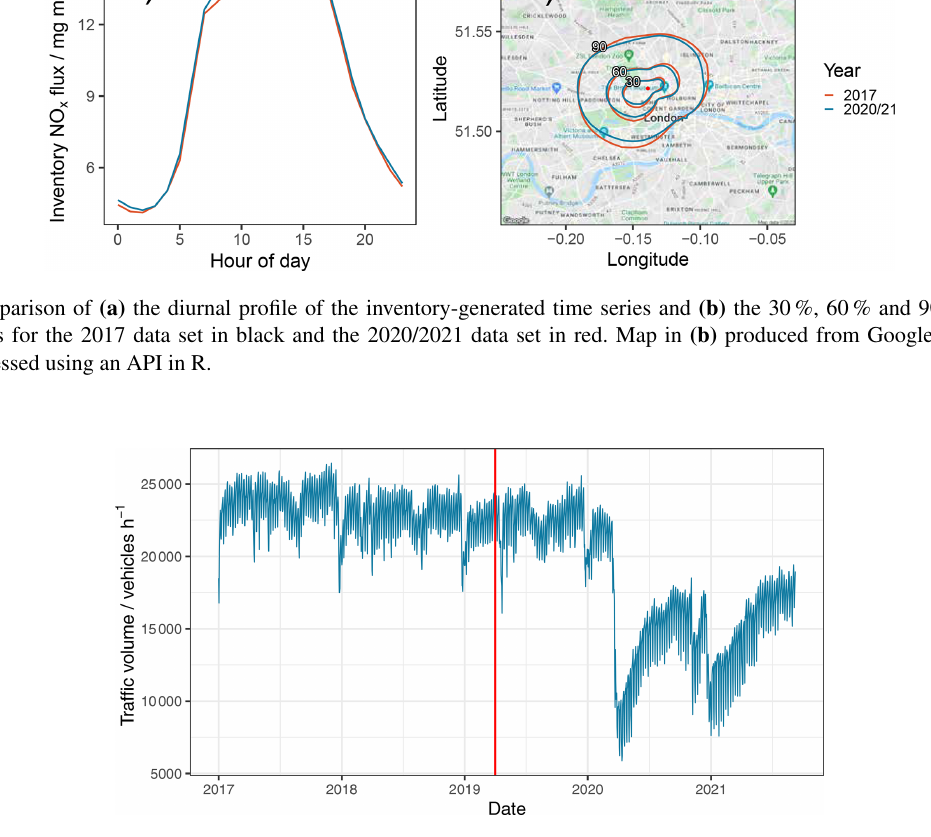
Figure A3. Daily average traffic load from 1 January 2017–1 September 2021. The date of the introduction of the ULEZ is marked as a vertical red line.